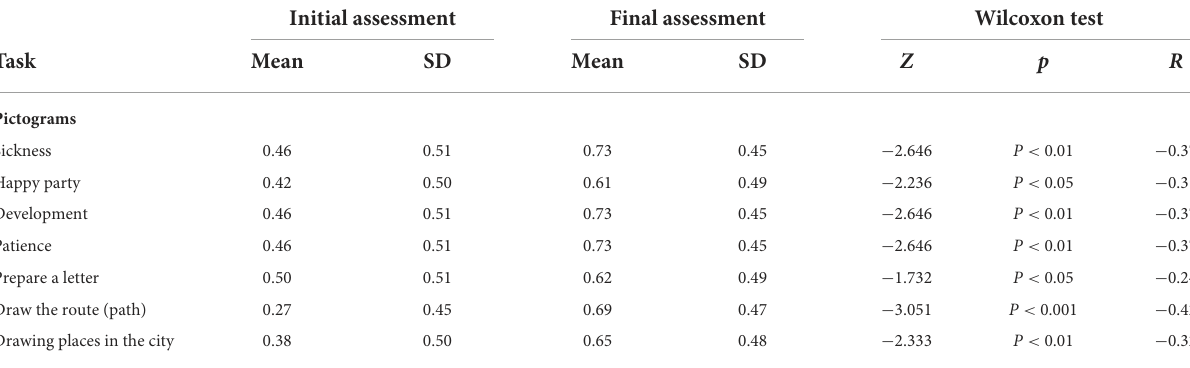
TABLE 4 Statistical results of qualitative analysis for the parameter Maintains the objective in the